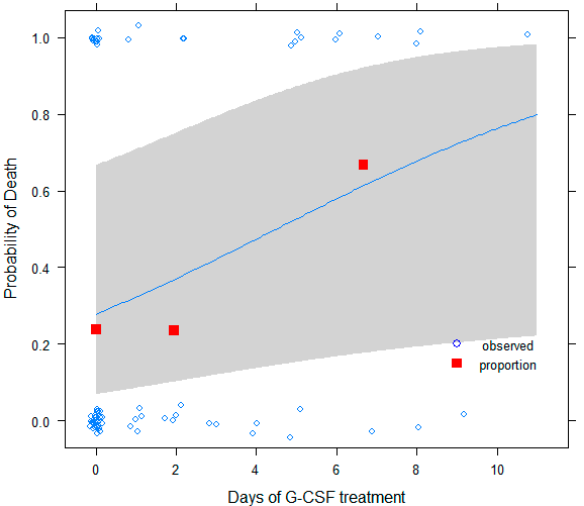
Figure 1. Death probability as a function of G-CSF treatment days: observed data (open circles, fitted to ease visualization), proportions (red squares, in subgroups of <1, 1–4, and >4 days), and fitted logistic model with 95% confidence bands are shown.